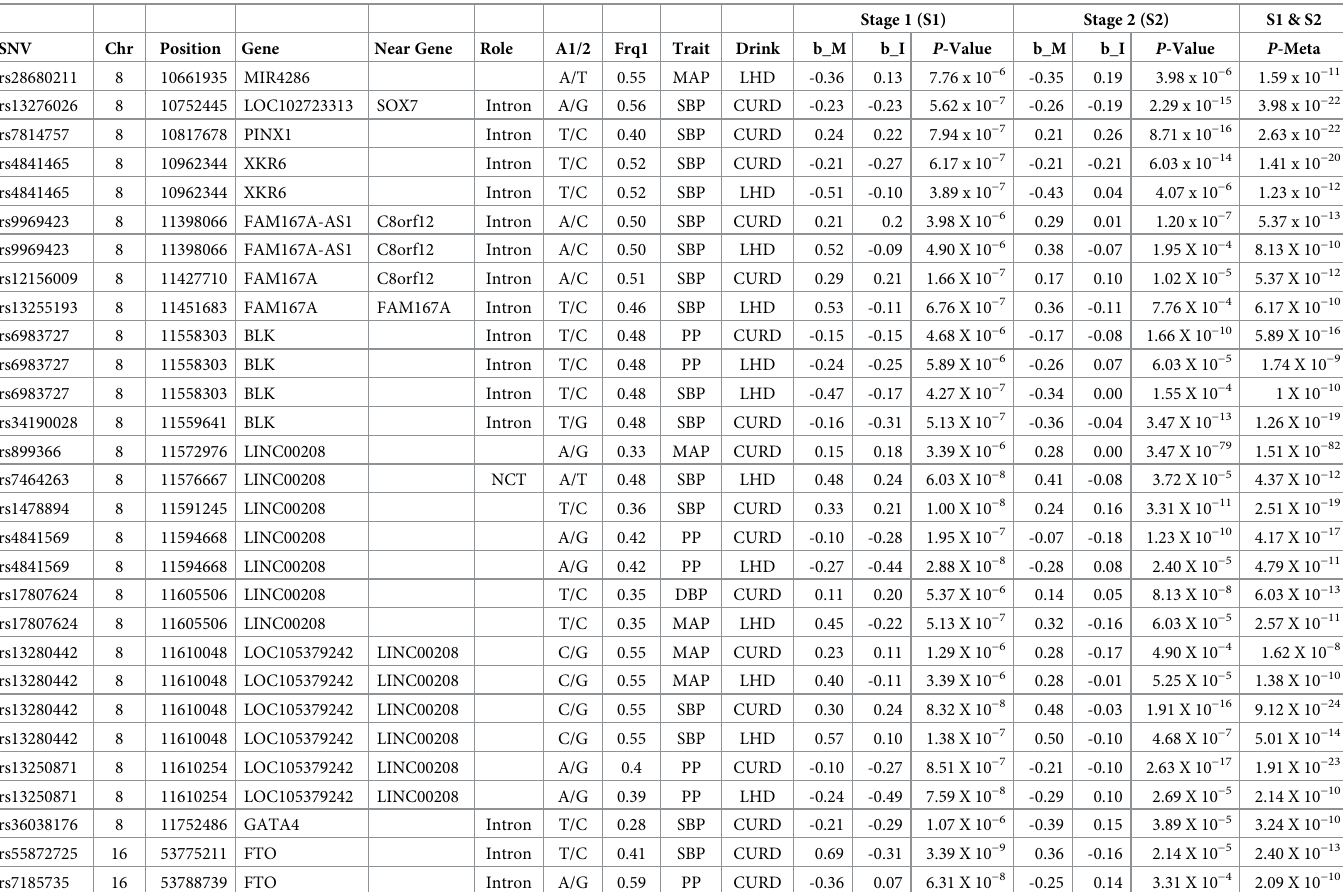
Table 2. Novel SNVs/Genes associated with BP traits in European